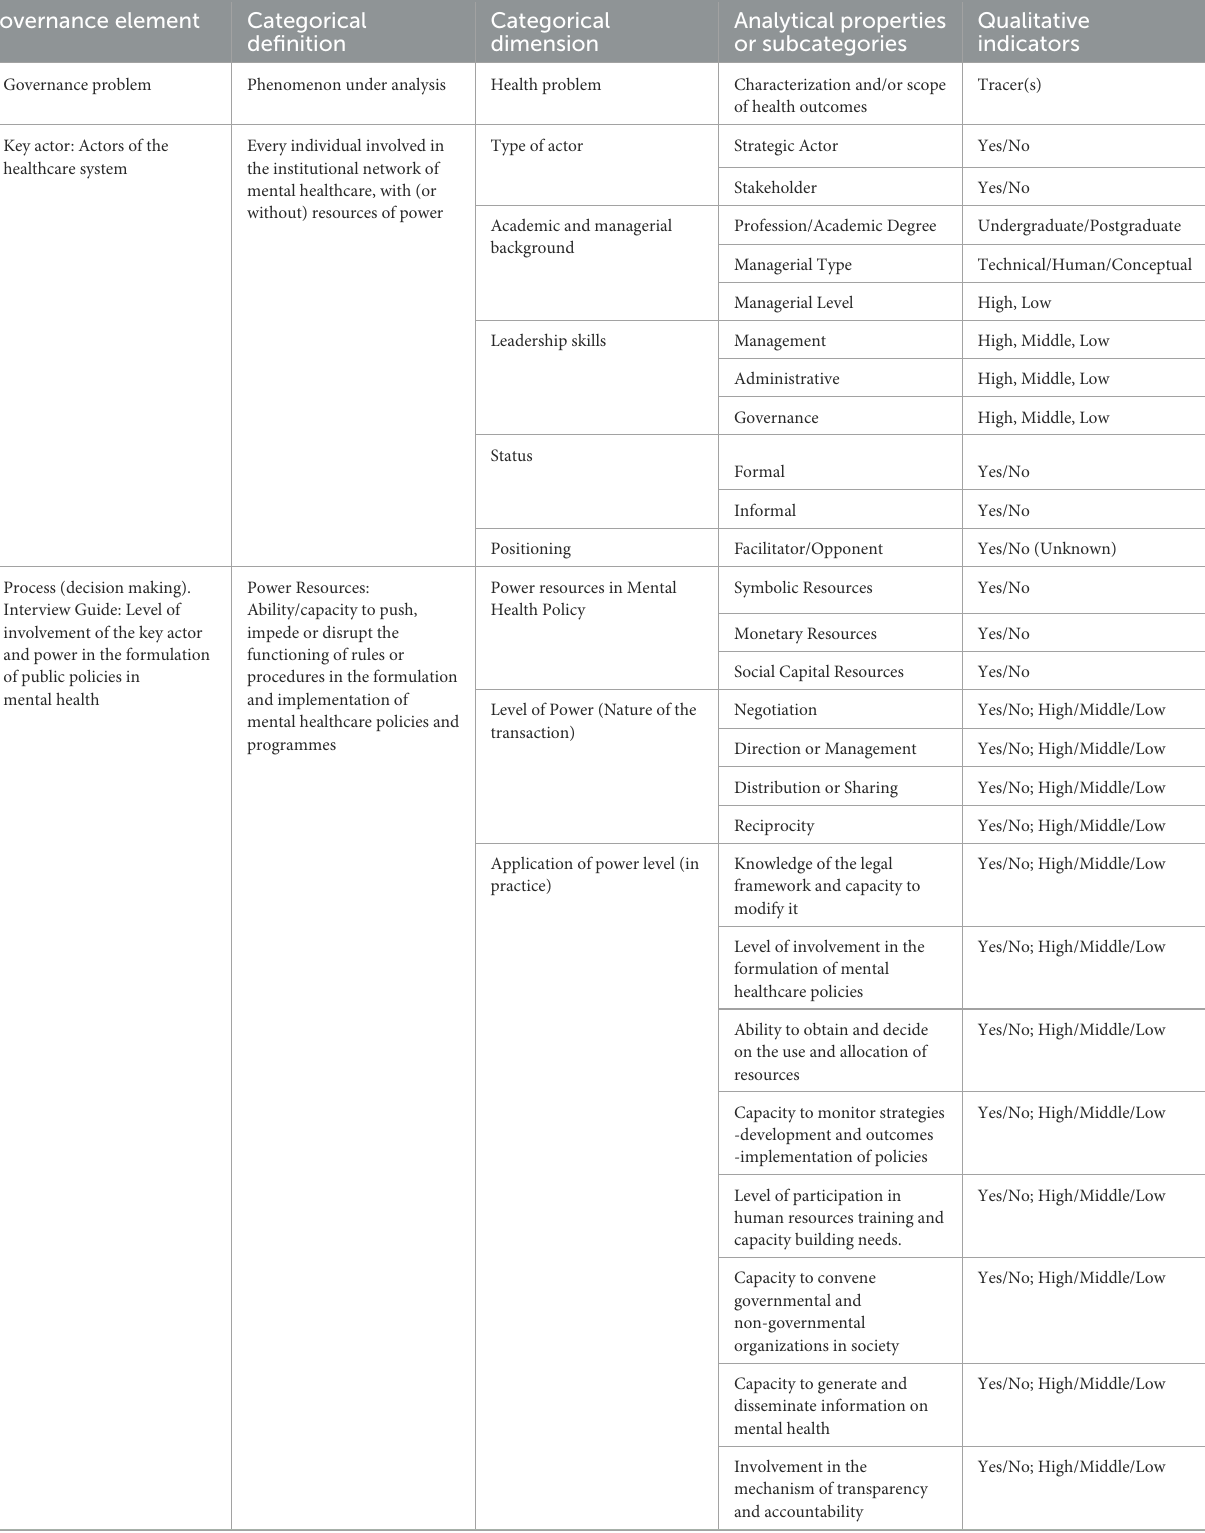
TABLE 1 Governance Analytical Framework